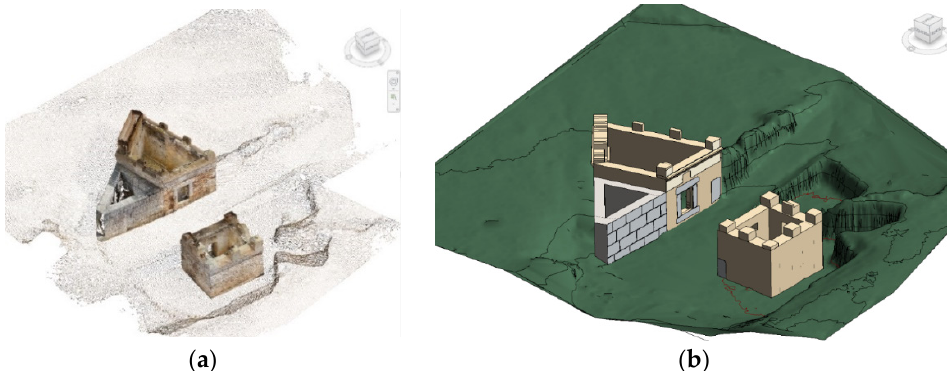
Figure 18. Different visual styles of the model. ( a ) Full point cloud view (buildings and topography) in Revit. ( b ) View of the Revit model of the buildings and topography.